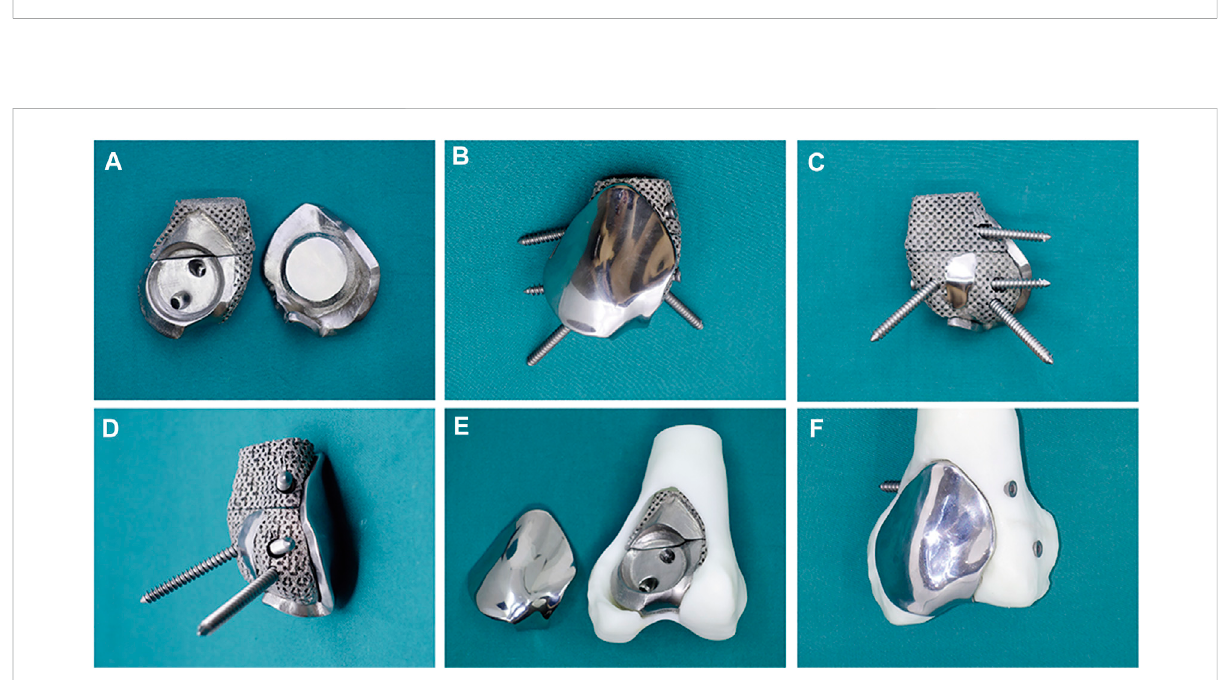
FIGURE 2 (A) Anterior view of the bone and articular cartilage defects and the circular 3D-printed guided plate. (B) Anterior view of the back components with four screw holes in three directions. (C) Anterior view of the front component connecting smoothly with the adjacent articular surface and two horizontal screws directed by guided plate. (D) Posterior view of bone defects. (E) Anterior and (F) lateral view of the 3D-printed modular prosthesis.